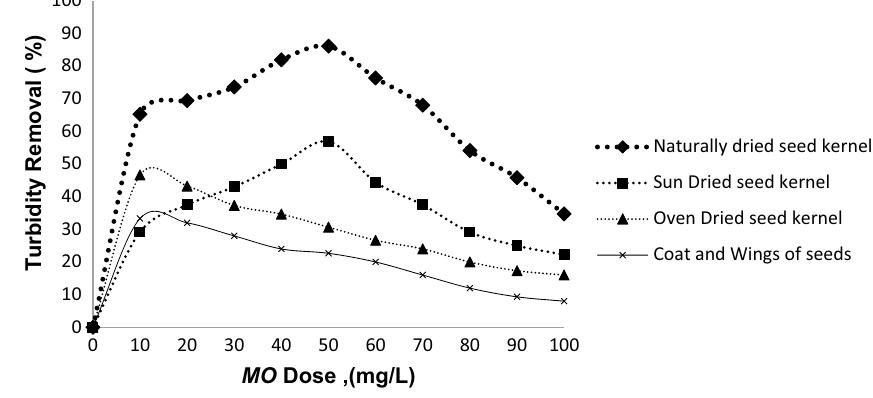
Fig. 1 Effect of coat and seed kernel of Moringa oleifera on turbidity removal